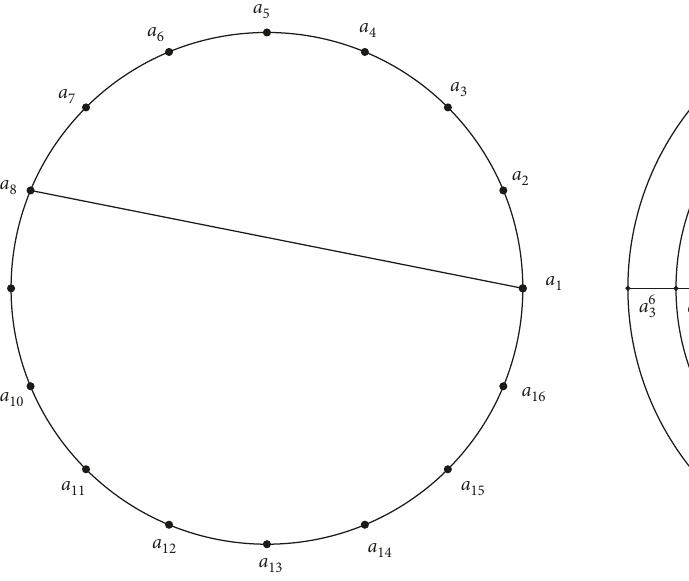
Figure 4: Graph of C